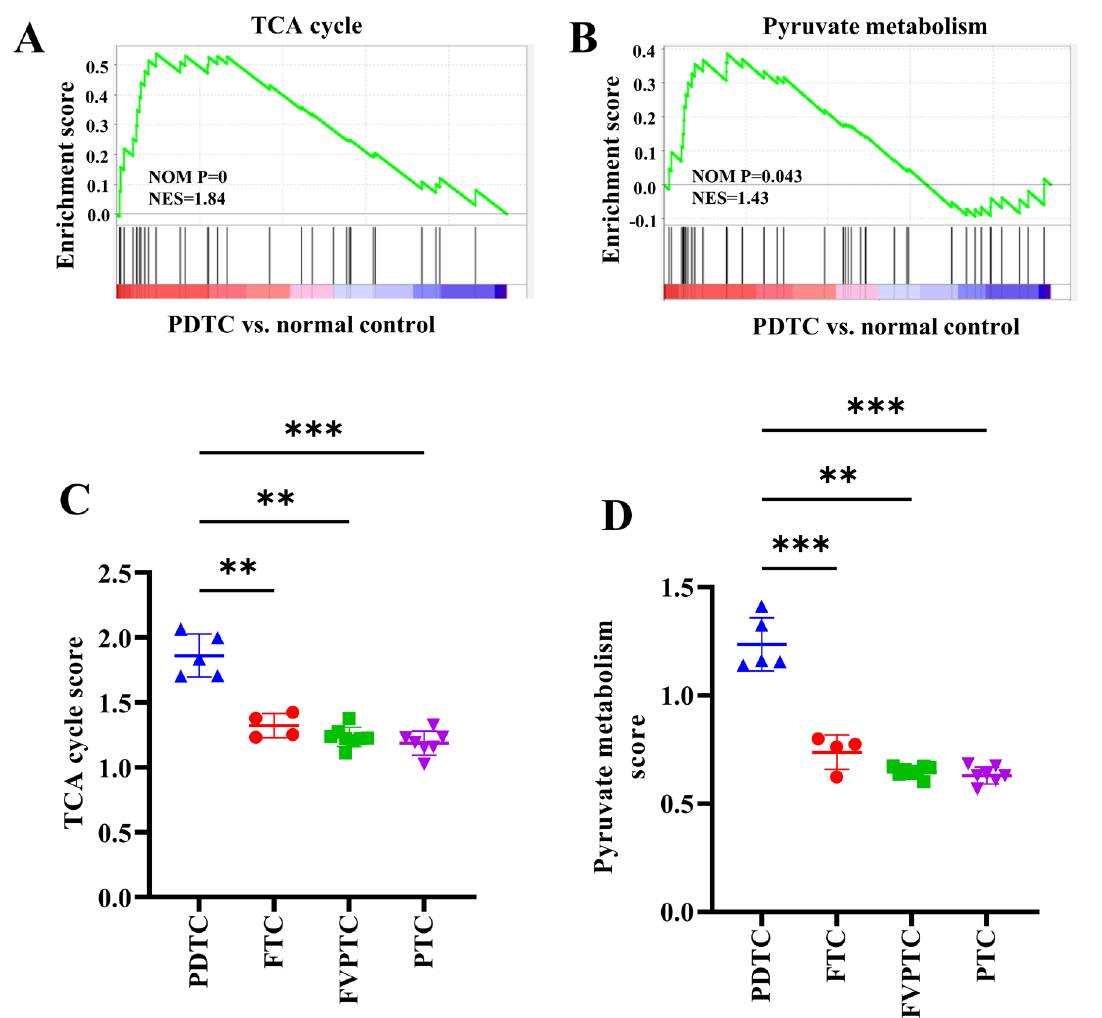
Figure 2. Enrichment of glucose metabolism-related pathway of PDTC. (A/B) GSEA showed that TCA cycle (A) and pyruvate metabolism pathways (B) were significantly enriched. (C/D) TCA cycle (C) and pyruvate metabolism (D) scores of PDTC, FTC, FVPTC and PTC. ANOVA followed by Tukey’s post hoc test was applied to compare the difference among groups. **P<0.01,